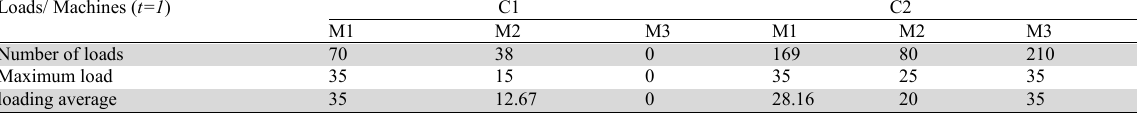
Results of machine loads in first period of final solution Loads/ Machines ( t=1 )